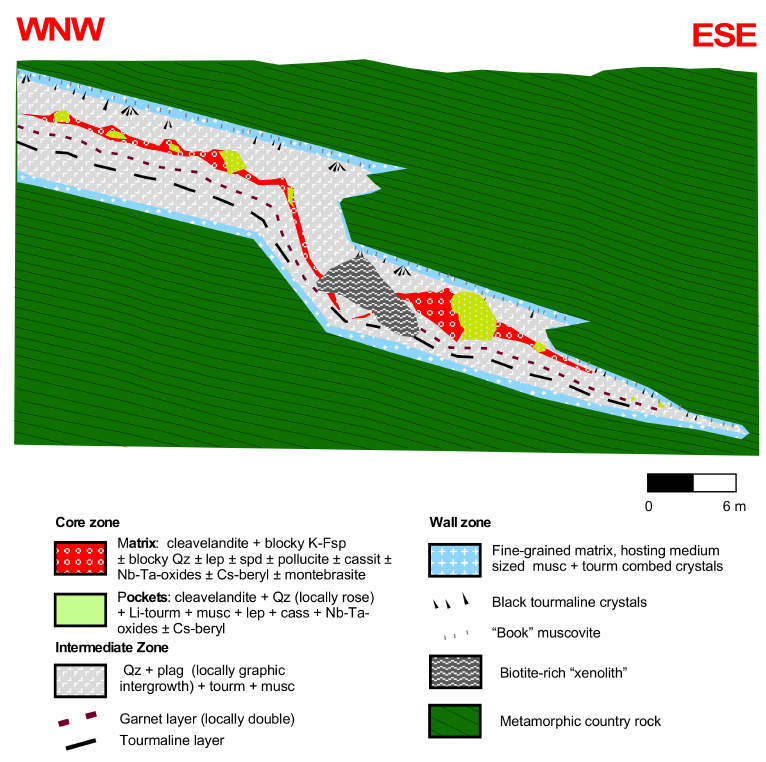
Figure 2. Idealized cross-section of the Mt. Mica pegmatite. Modified from Roda-Robles in [36].